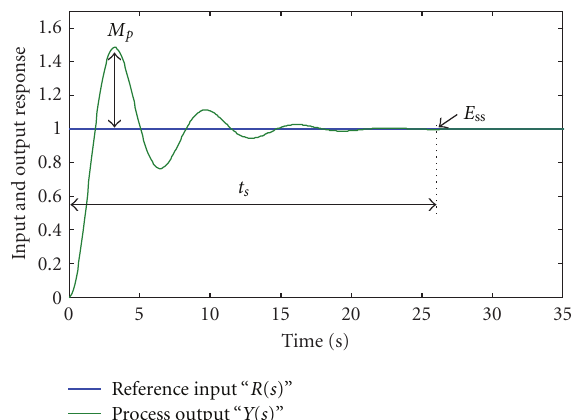
Figure 5: Closed loop response of the system.